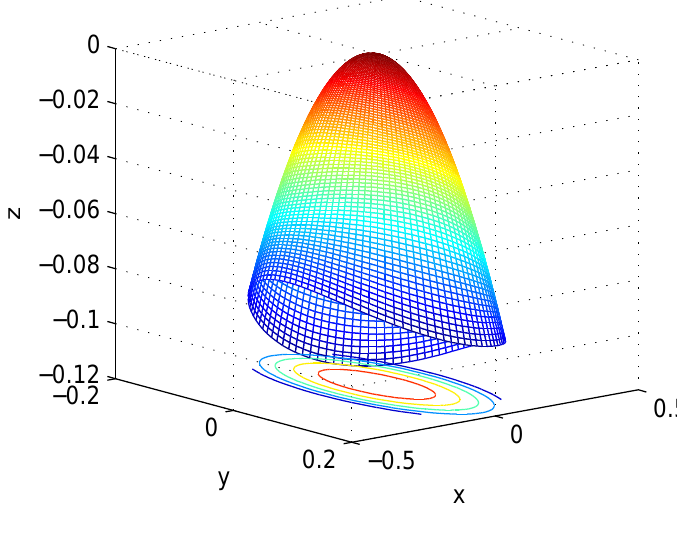
Figure 11. Numerical simulation of the mode shape.